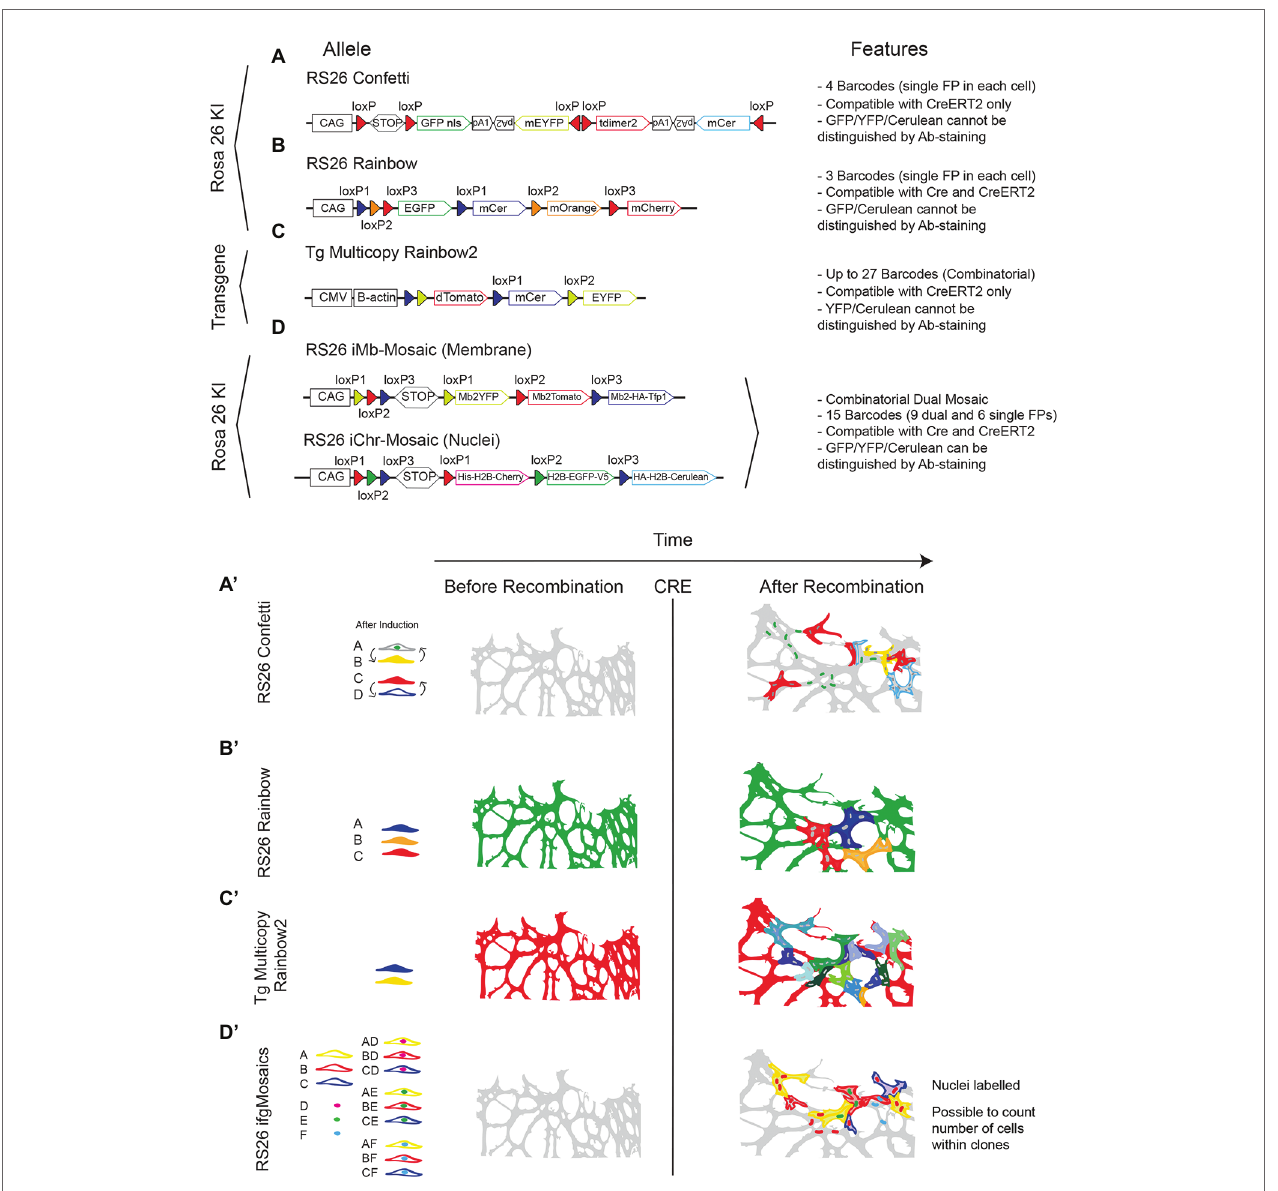
FIGURE 5 | Multispectral fluorescent mosaic alleles. (A-D) Schemes of the alleles and main features of available mouse lines to induce stochastic fluorescent genetic mosaics in all cell types. (A’-D’) Illustration showing the comparison of the endothelial cell labelling achieved before and after Cre activity. Note the difference in colors/channels and cellular/clonal